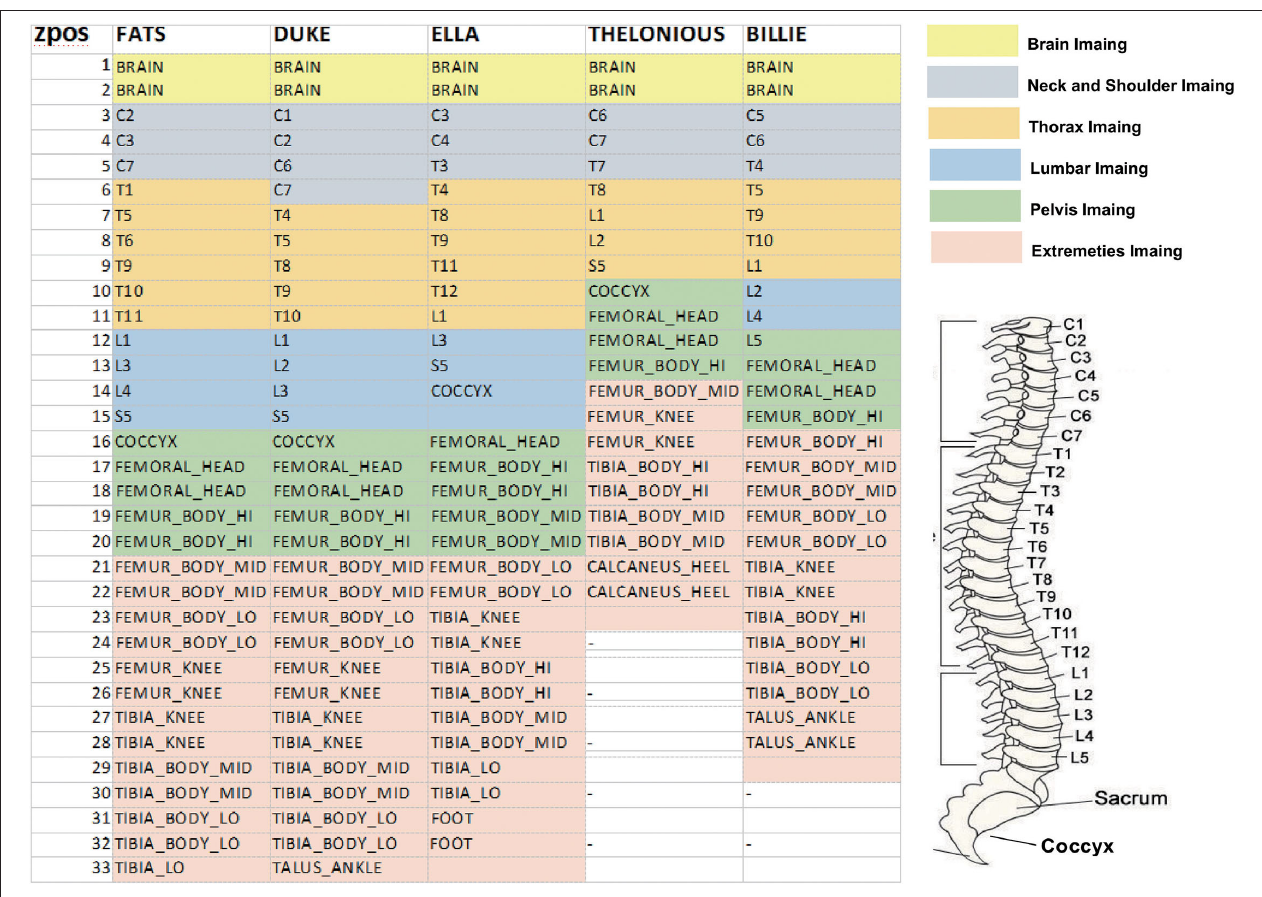
FIGURE 2 | Illustration of the corresponding anatomical marks in each anatomical model for each imaging position (ZPOS), different color represents different imaging range.